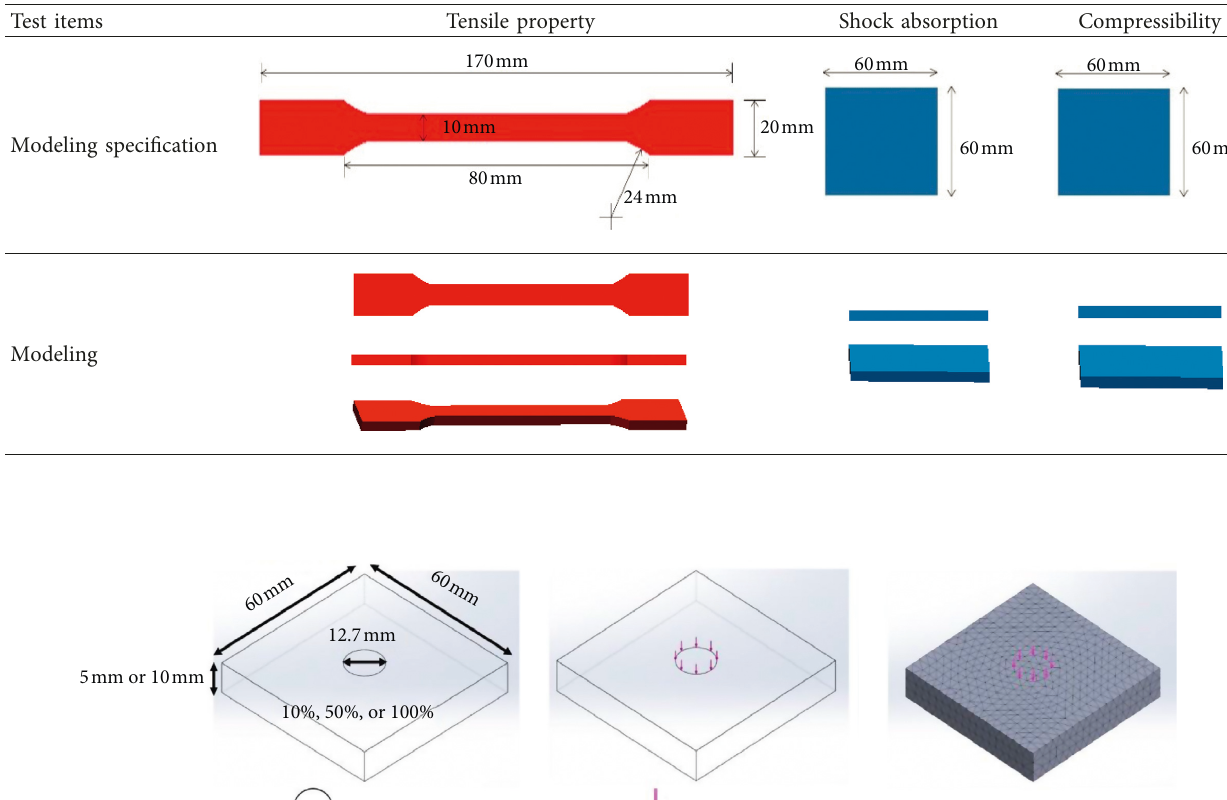
Table 3: 3D modeling